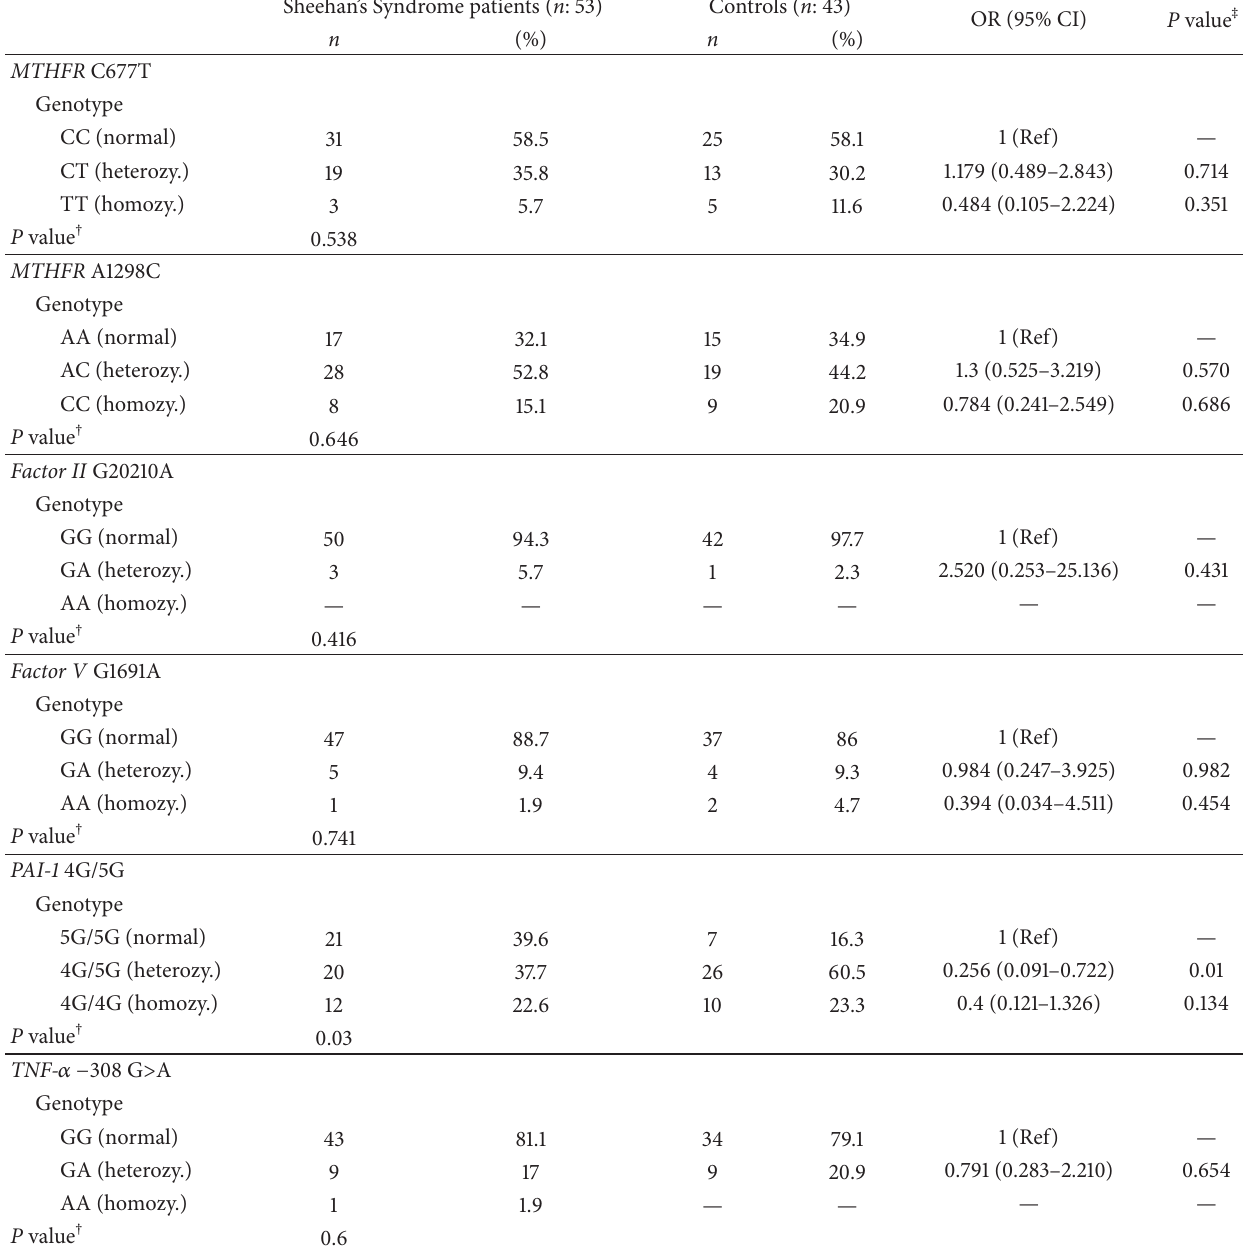
Table 2: Distribution of thrombophilic and cytokine genes among Sheehan’s Syndrome cases and controls. Sheehan’s Syndrome patients ( n :